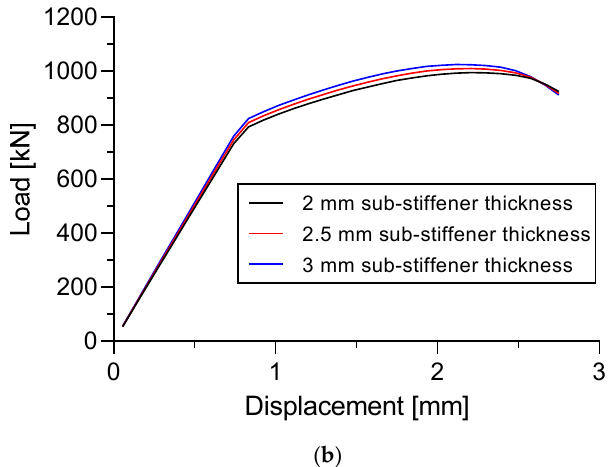
Figure 22. Effect of stiffeners thickness to the load versus displacement curve. ( a ) Specimen A; ( b ) Specimen B.